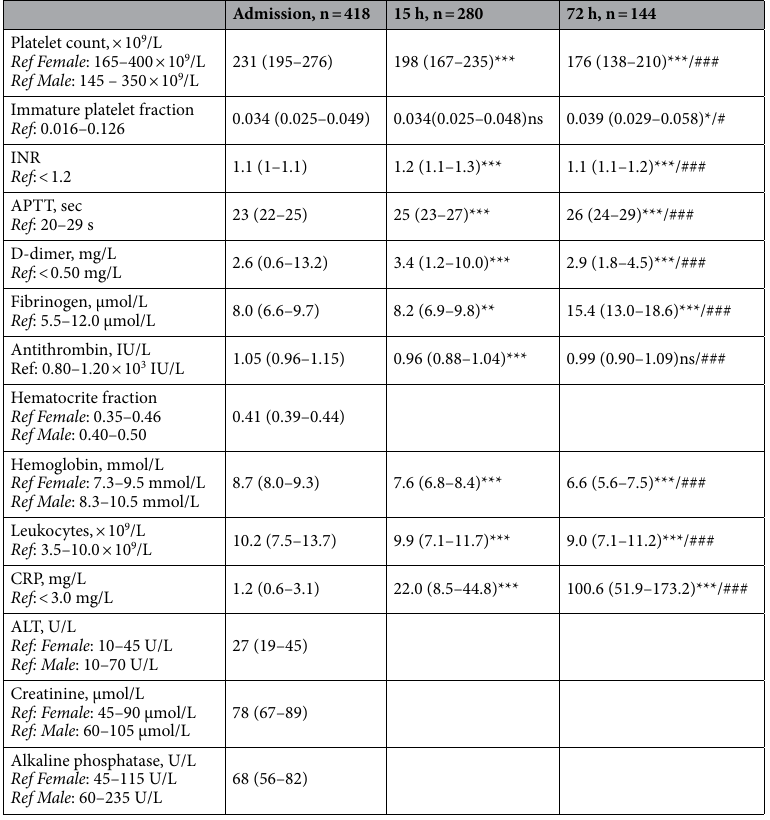
Table 2. Laboratory parameters among trauma patients during the initial 72 h of hospital stay. Values displayed as median (interquartile range). Abbreviations: ALT Alanine aminotransferase, APTT Activated partial thromboplastin time, CRP C-reactive protein, INR International Normalized Ratio, Ref Reference range. */**/***: p < 0.05/0.01/0.001 against admission level. #/##/###: p < 0.05/0.01/0.001 against 15 h